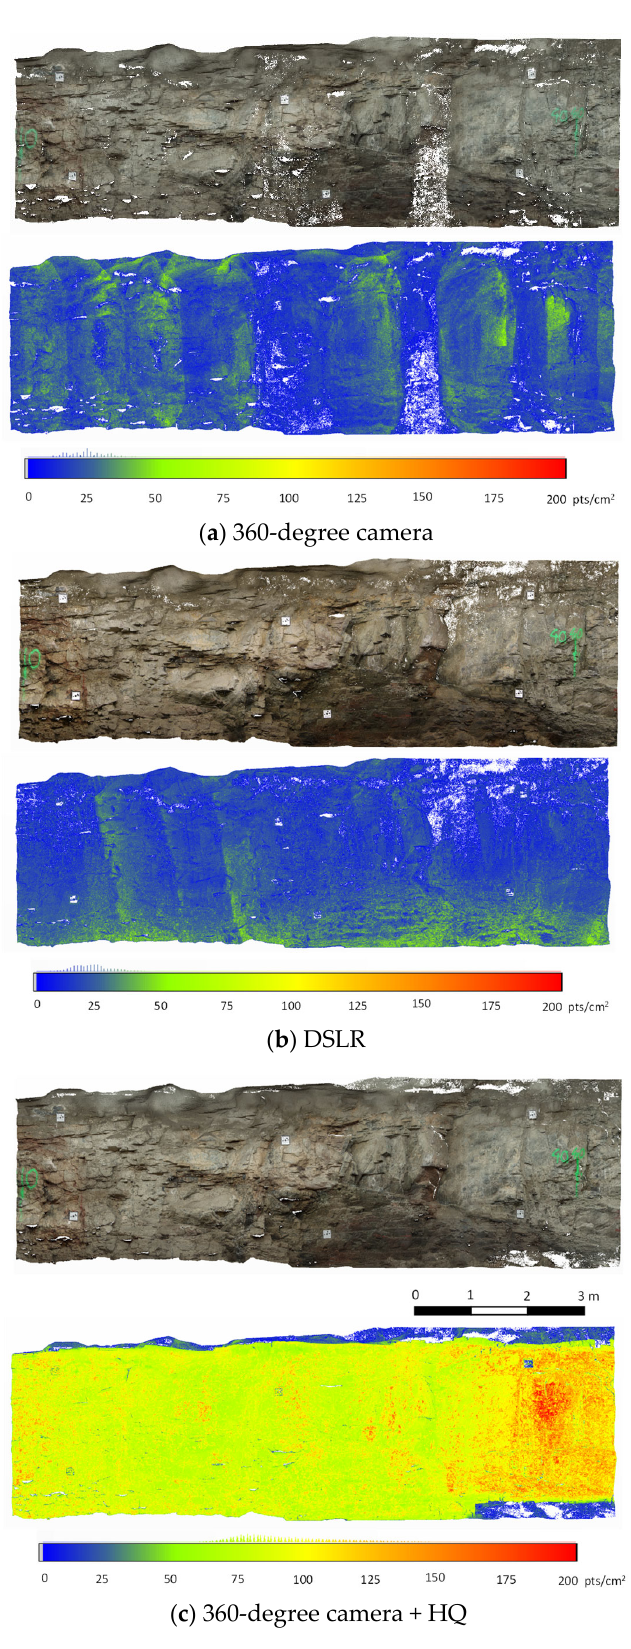
Figure 7. 3D point clouds and surface point density of the tunnel wall digitized with: ( a ) 360 ‐ degree camera ‐ based photogrammetric model, ( b ) DSLR model for comparison, and ( c ) an improved model with additional DSLR images of the tunnel wall.